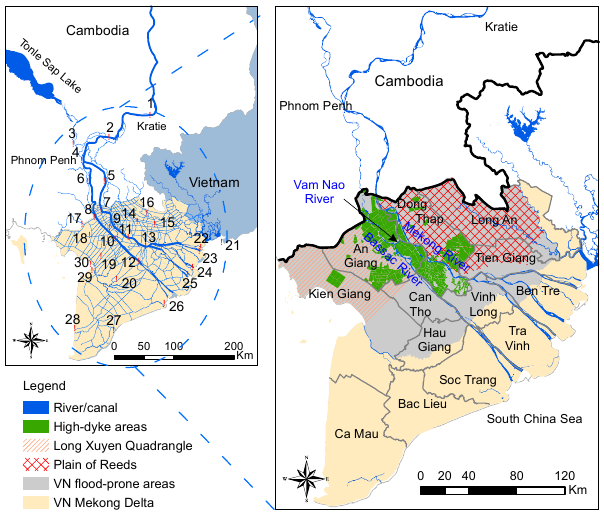
Figure 1. The Vietnamese Mekong Delta, its flood-prone areas and the location of measuring stations (red dots). The names in black indicate the provinces in the